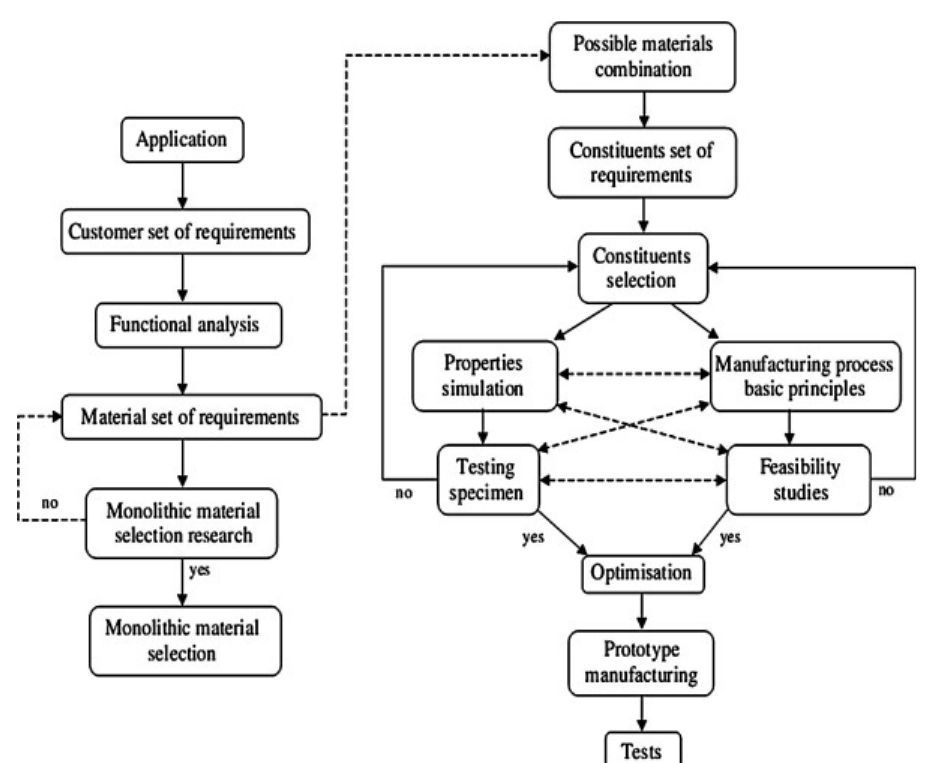
Figure 7. An example of the multi ‐ material selection algorithm for lightweight design, taking into account product recyclability